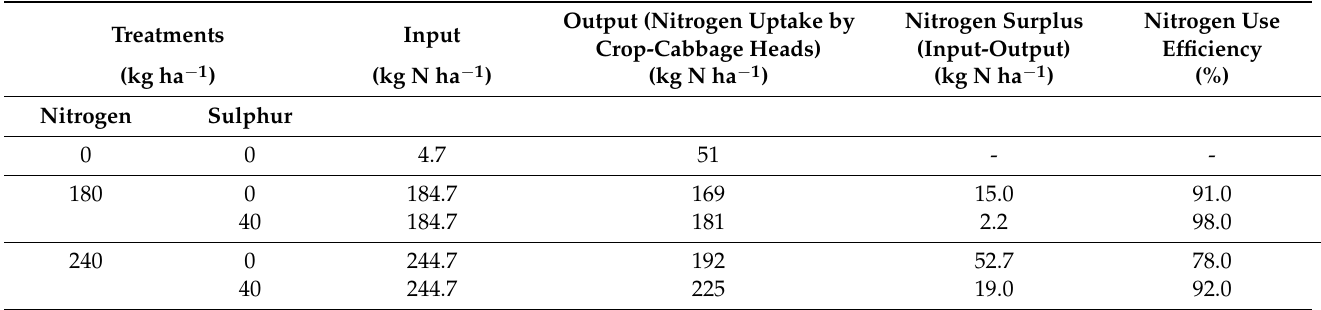
Table 5. Nitrogen balance: inputs and